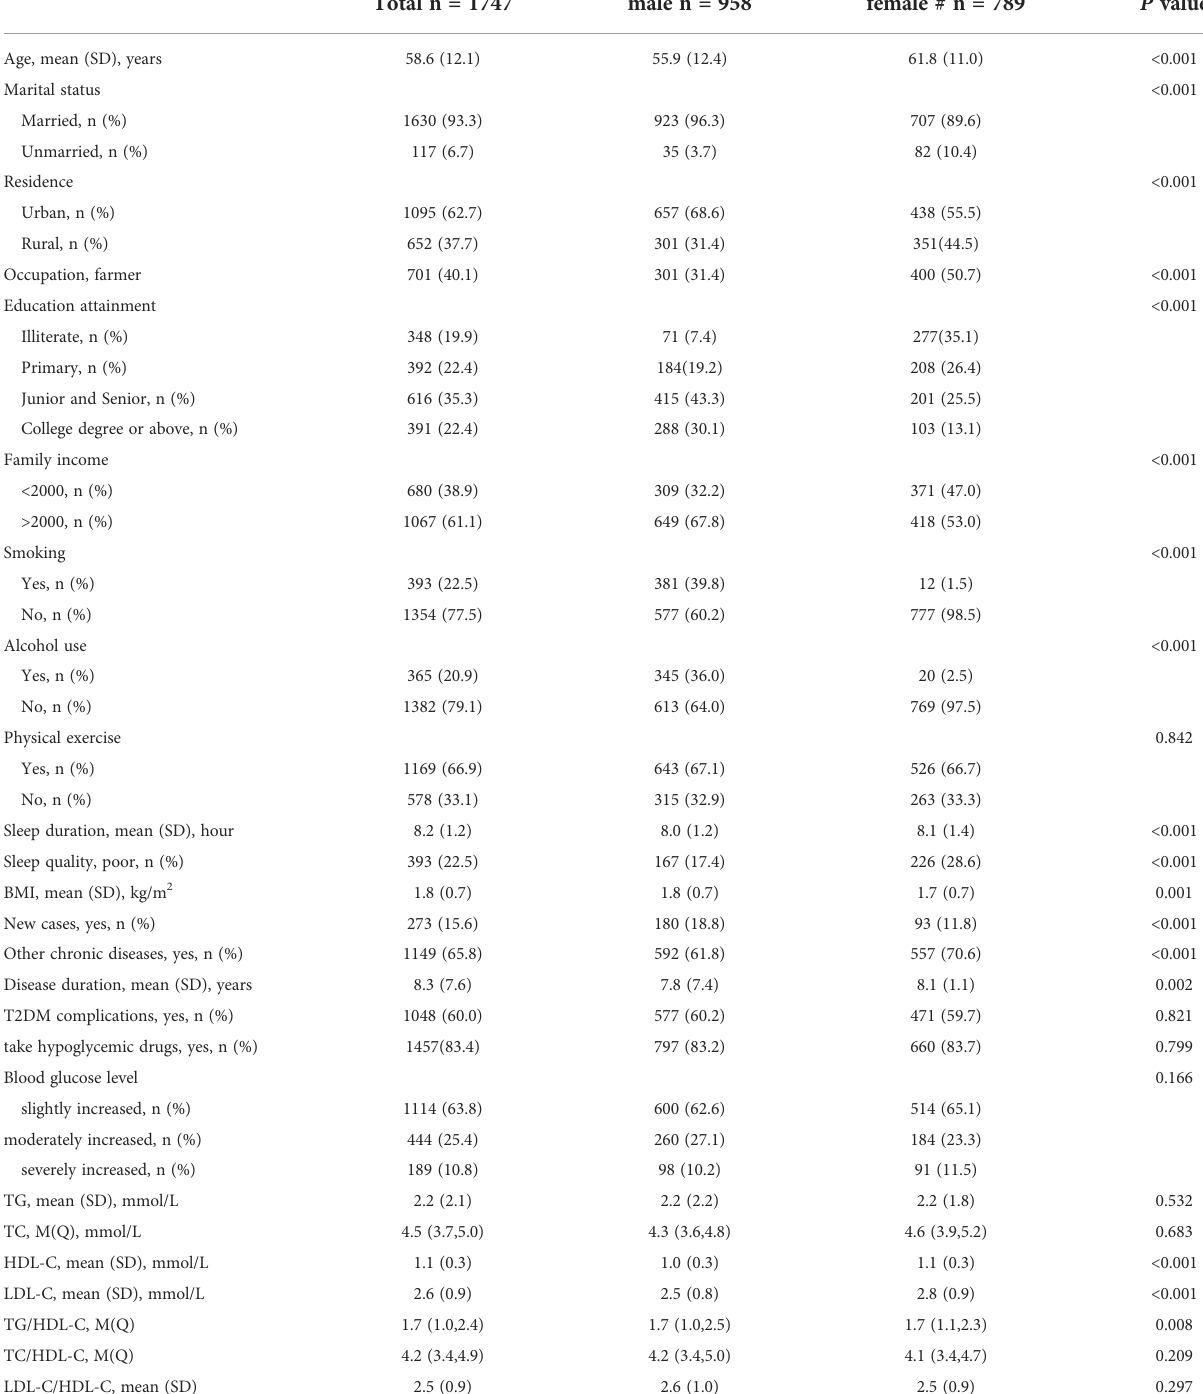
TABLE 1 Demographic characteristics of